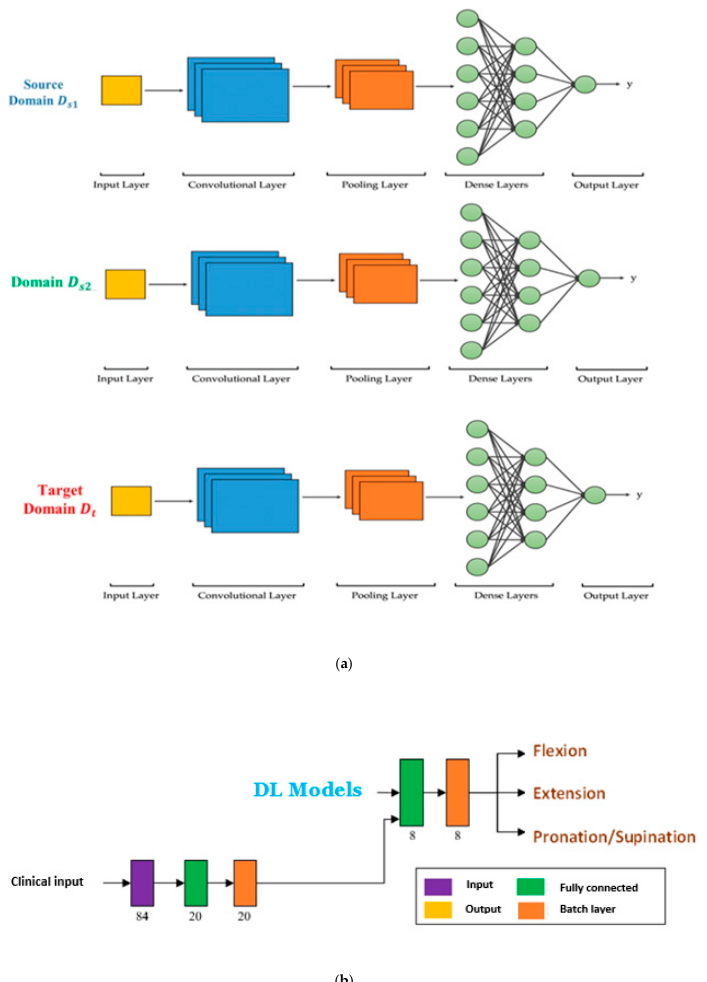
Figure 4. ( a ) The architecture of the transfer learning training; ( b ) the architecture of prediction from actual labeled clinical